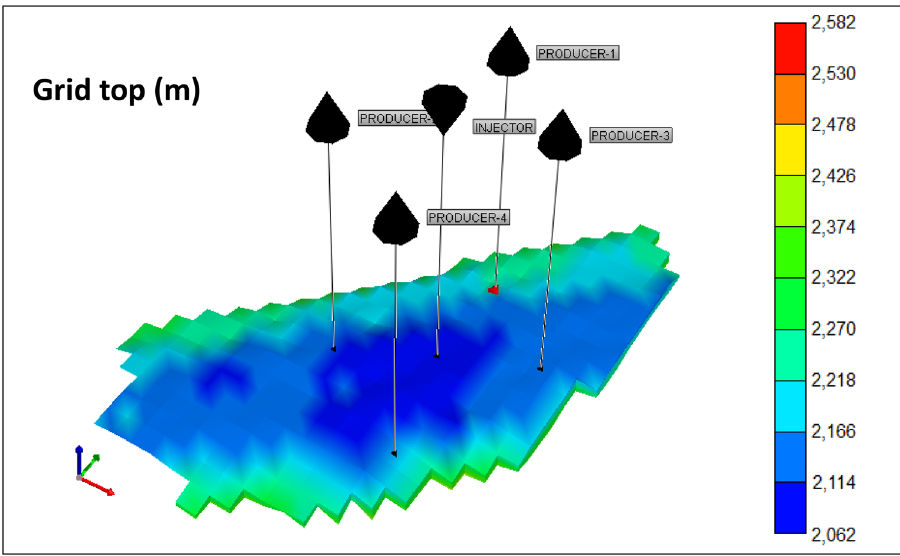
Fig. 15 Five-spot quarter model designed for well optimization